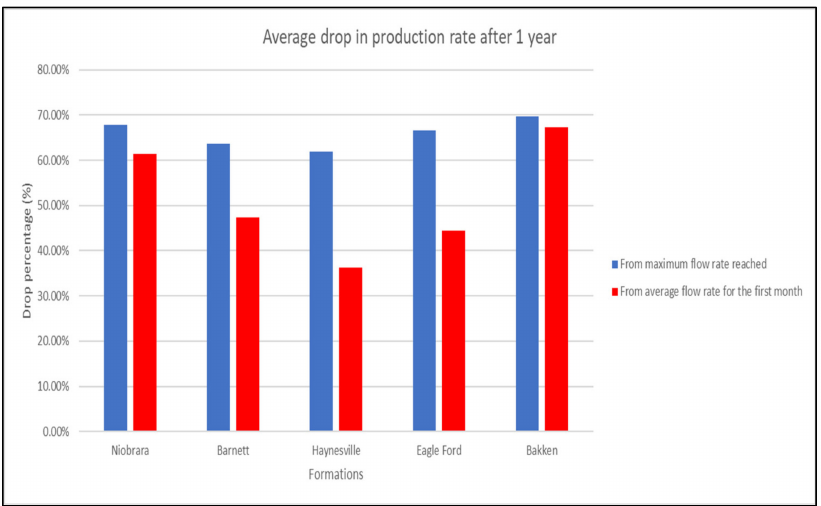
Figure 3. Average drop in production from the maximum flow rate reached and from average flow rate for the first month within one year.